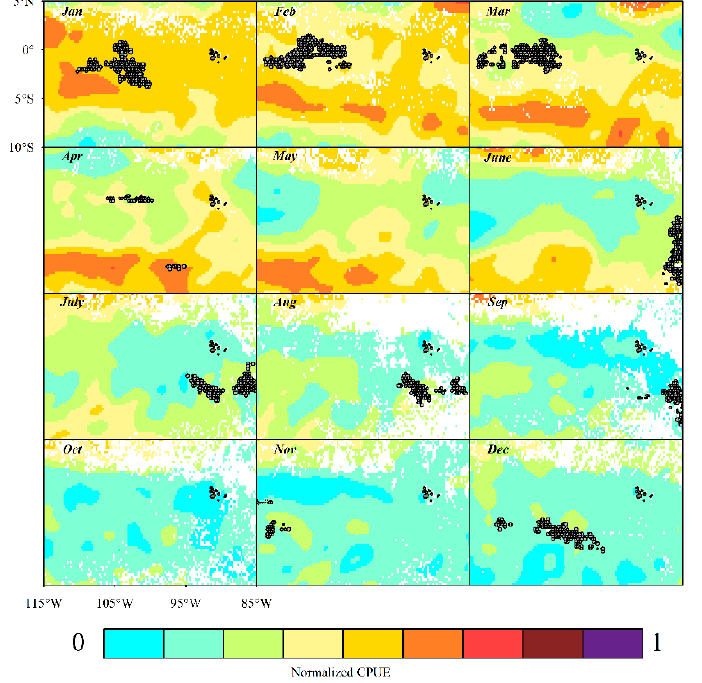
Figure 7. Monthly distribution of GAM standardized CPUE and predicted CPUE for squid-jigging fishery in the equatorial waters of Eastern Pacific.